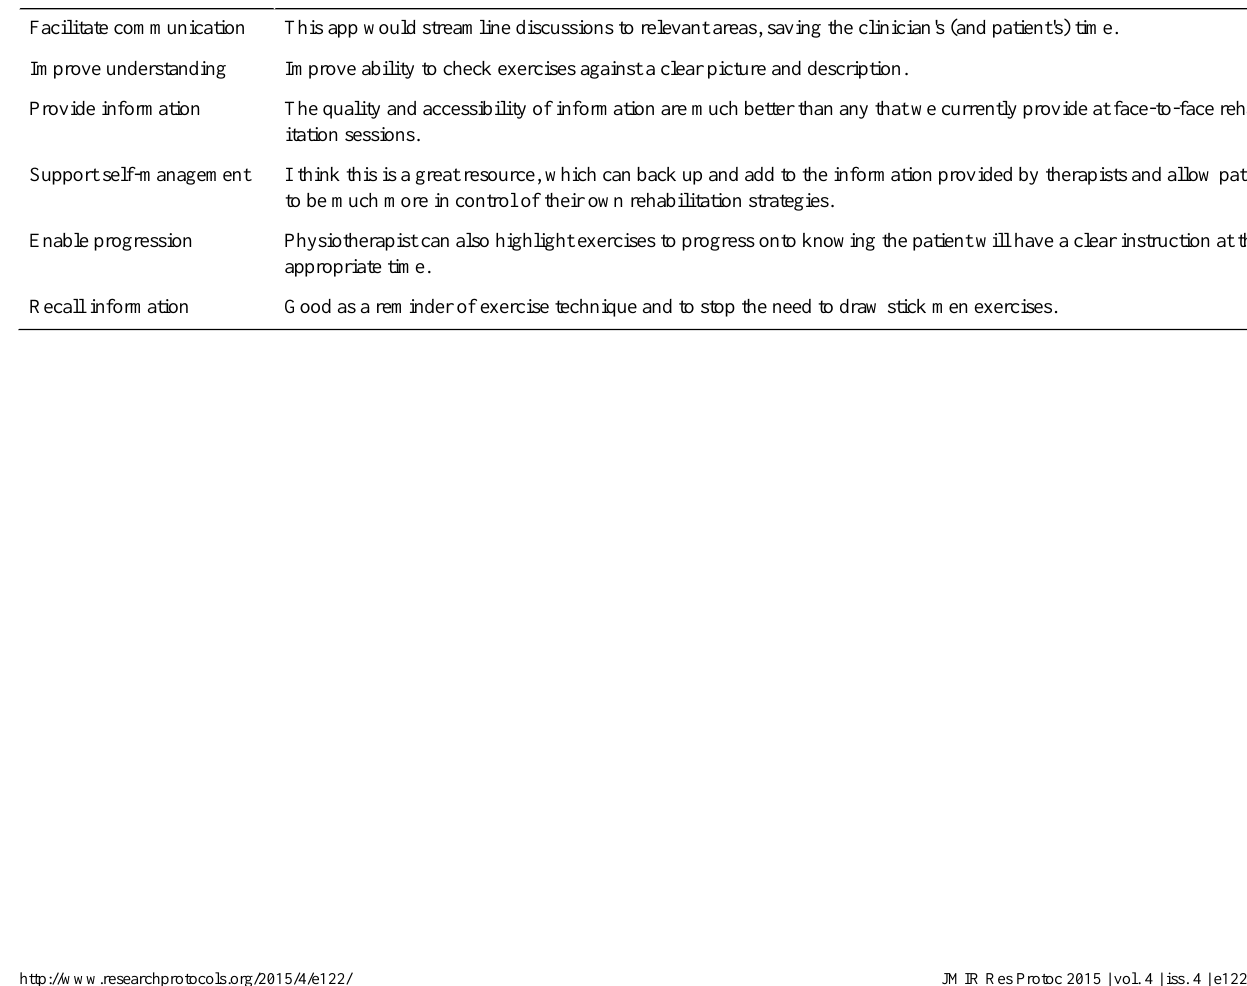
Table 2. A sample of physiotherapists' opinions on the extent to what the app could support face-to-face appointments.